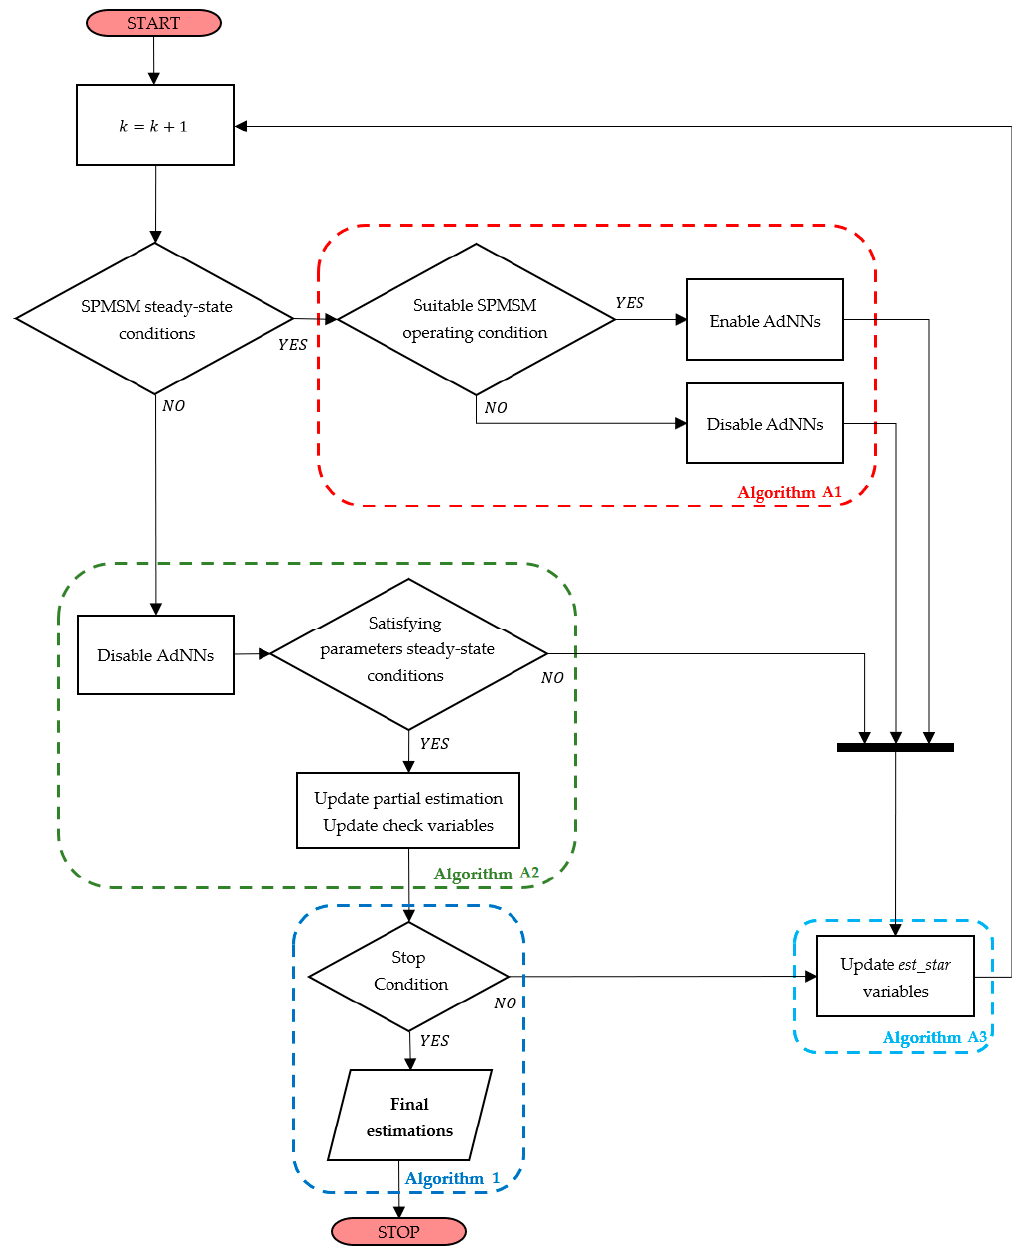
Figure 2. Flow chart of the proposed